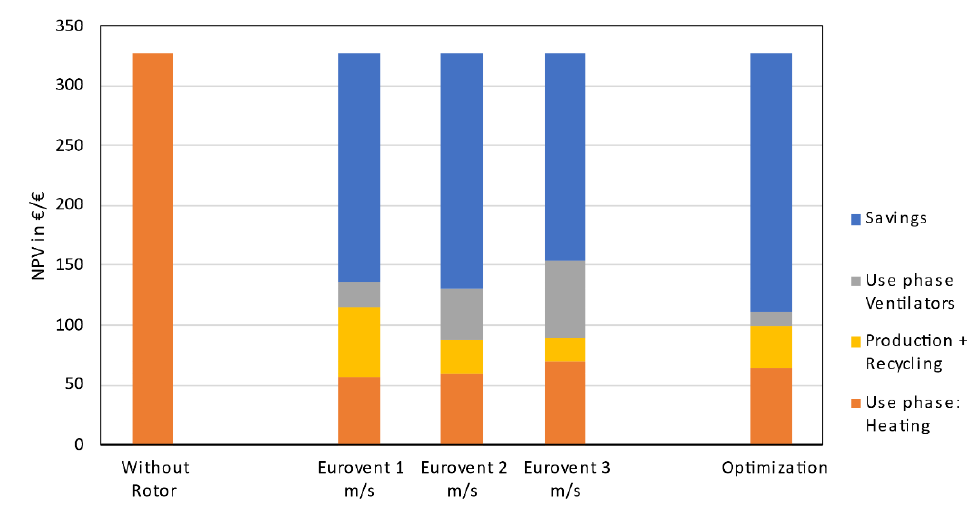
Figure A3. 55 €/t CO 2 Eq. scenario with optimized RHX and Eurovent RHX under different operating ambient air empty tube velocities at 100,000 m 3 /h.